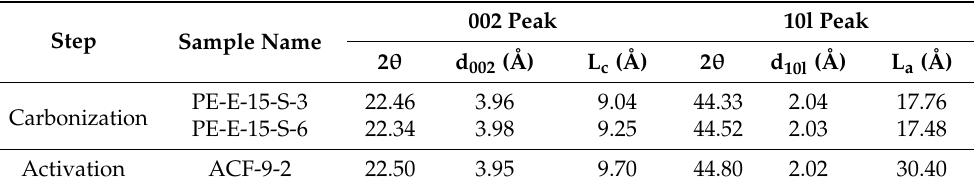
Table 3. XRD patterns of hybrid crosslinked LLDPE fibers after carbonization and activation.